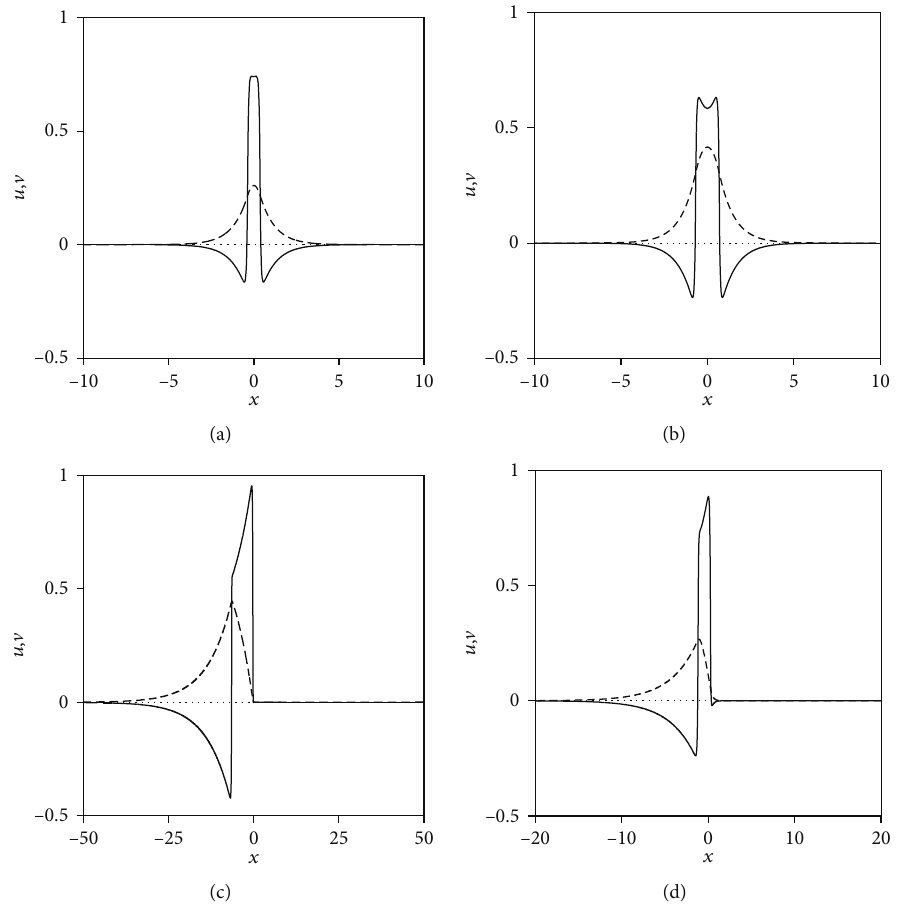
Figure 1: Pro fi les of the pulse in the RD system (1) under periodic boundary conditions. Solid and dashed curves represent u and v , respectively. L = 5 0. (a) Standing pulse. τ = 0 .4 and α = 0 . (b) Standing pulse. τ = 0 .4, α = 3 , and s α = 0 . (d) Traveling pulse. τ = 0 .1, α = 3 , and s = 1 0